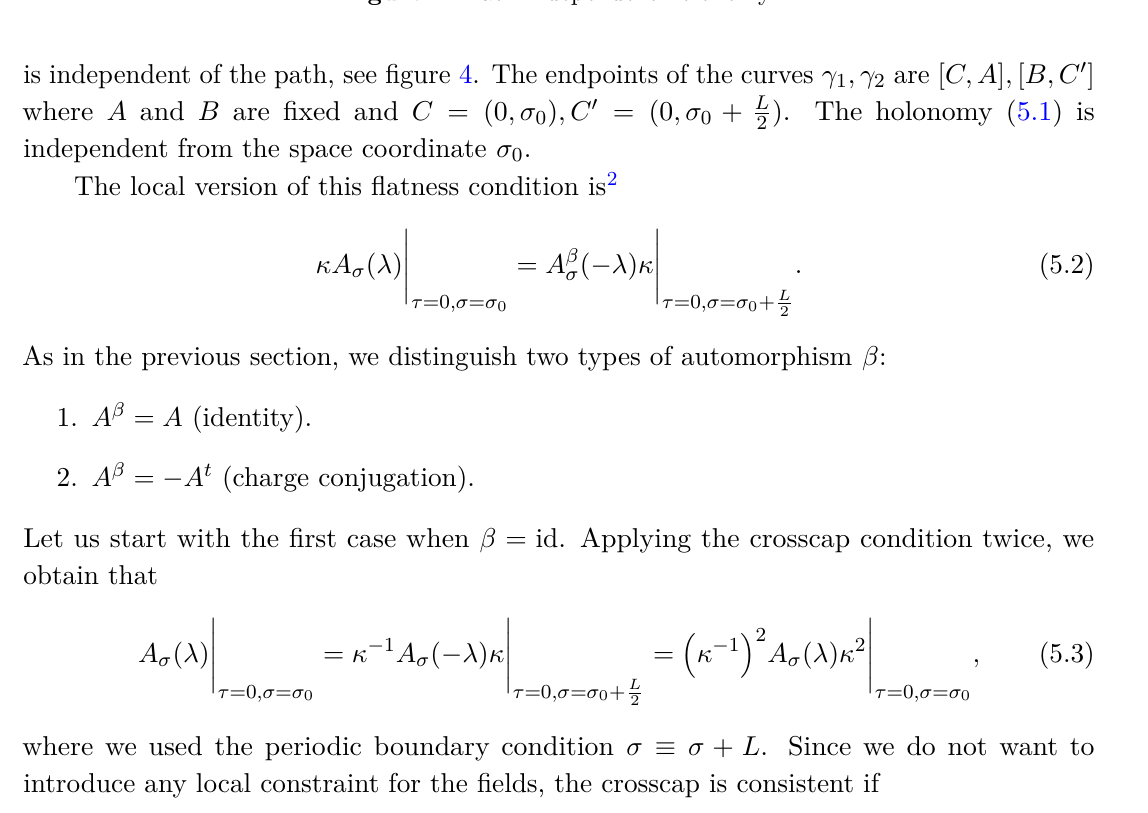
Figure 4 . Path independent